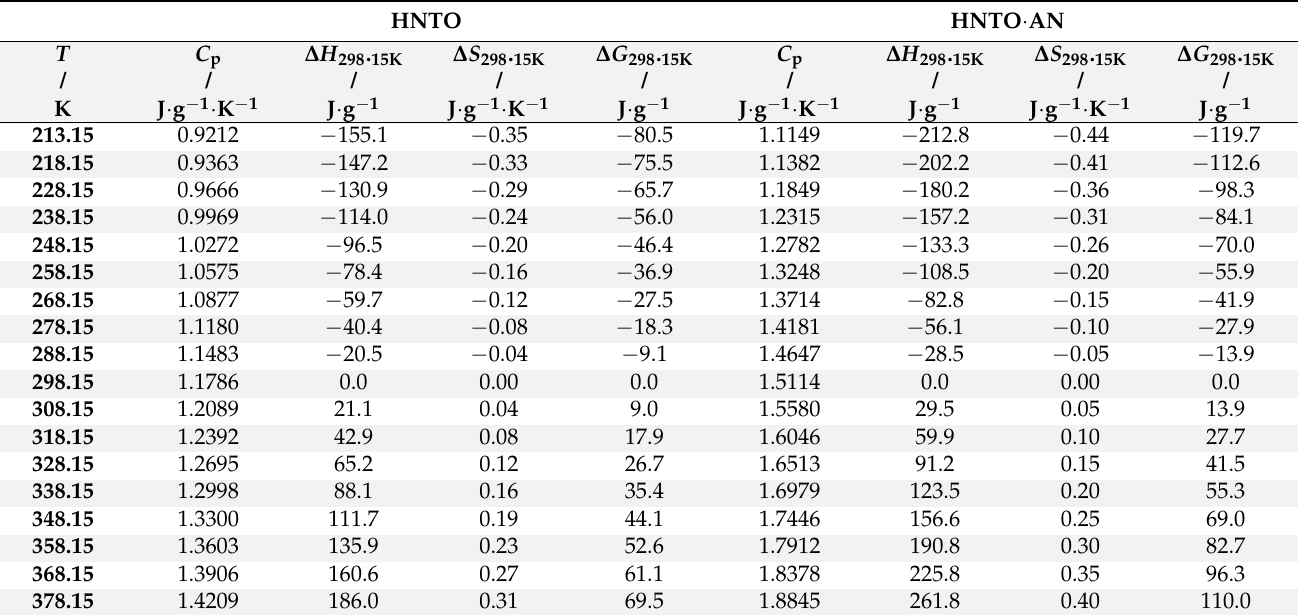
), entropy change ( S T − S T 0